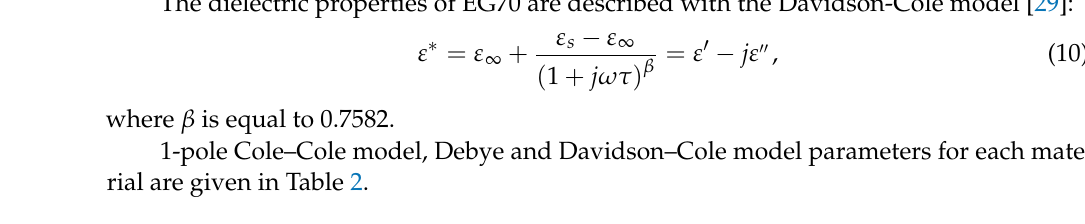
Table 2. 1-pole Cole–Cole model parameters of simulated